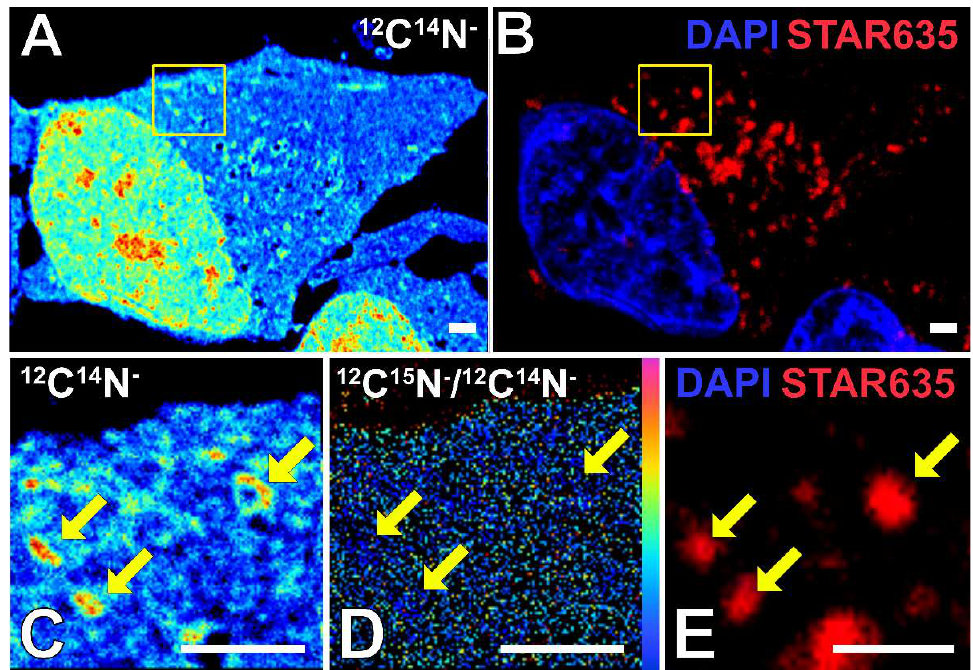
Figure 1. Example of correlating STED and NanoSIMS images for determining the 15 N enrichment of SGs. ( A ) 12 C 14 N − NanoSIMS image of a stressed cell showing the shape of the whole cell and nucleus. ( B ) STED image of the stressed cell. DAPI is labelled for nucleus (blue), and anti-G3BP antibody and secondary antibody STAR 635 are labelled for SG protein G3BP (red). ( C – E ) Zoomed-in images of the yellow box in ( A , B ); ( C ) 12 C 14 N − NanoSIMS image; ( D ) 12 C 15 N − / 12 C 14 N − NanoSIMS image; ( E ) STED image. The arrows point to the selected SGs. Scale bars are 2 μm.